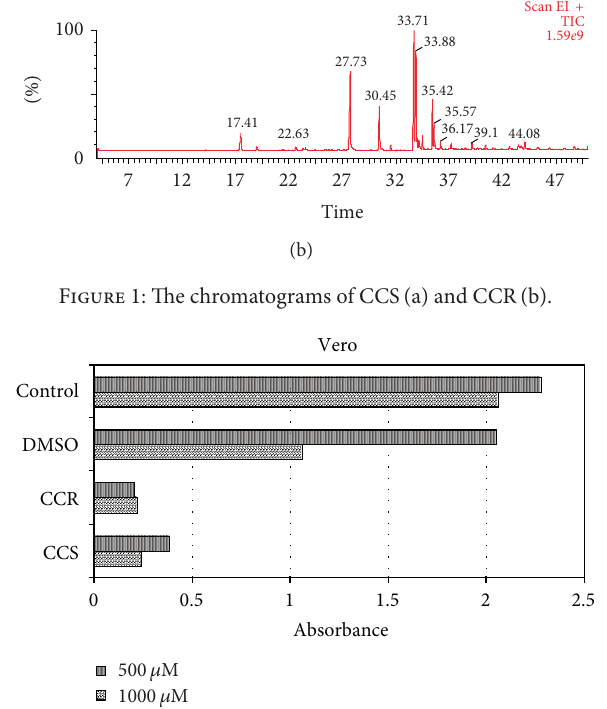
F 2: Antiproliferative effect of CCS and CCR on the Vero cells.